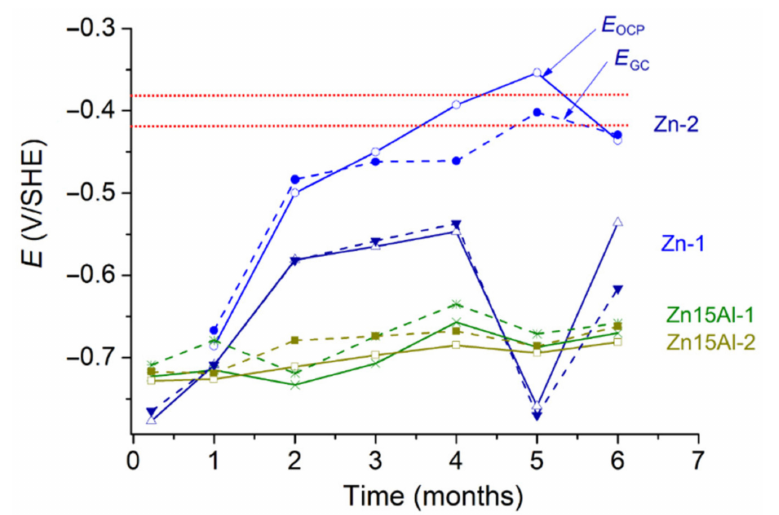
Figure 5. Evolution over time of mixed potential E GC (dotted line) and OCP of coated electrodes (full line) during the 6-month galvanic corrosion experiment. For galvanic couple Zn-2, the initial values were not measured. The horizontal dotted lines at − 0.38 V/SHE and − 0.42 V/SHE correspond to the average OCP value measured for carbon steel after 1 month, i.e., − 0.40 ± 0.02